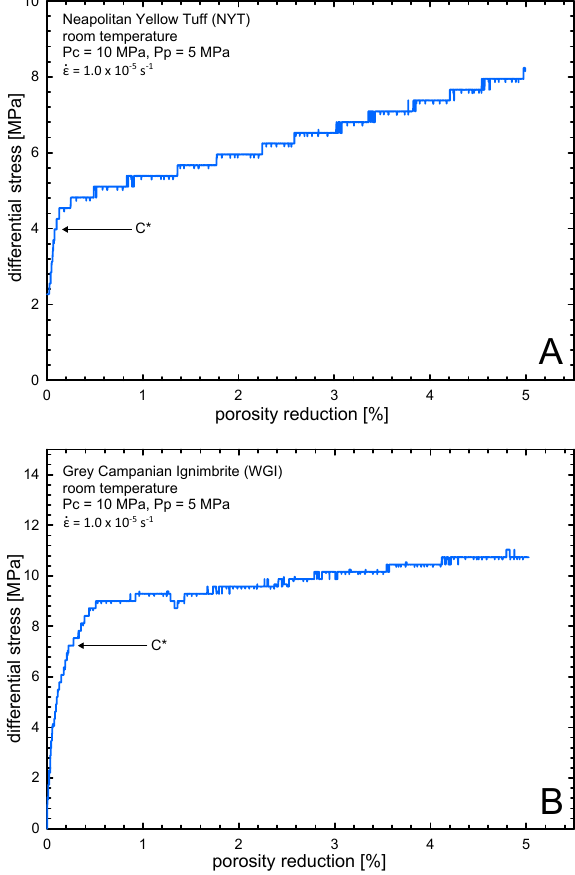
Fig. 10. Constant strain rate stress-porosity reduction curves for as-collected Neapolitan Yellow Tuff (A) and Grey Campanian Ig- nimbrite (B) . The experiments shown here are the same as those in Fig. 9. The experimental conditions are provided on each panel and the positions of C ∗ are indicated by the arrows. The steps in the data are due to the stepwise nature of the pumps. Note that the porosity reduction on the x axis is not a relative